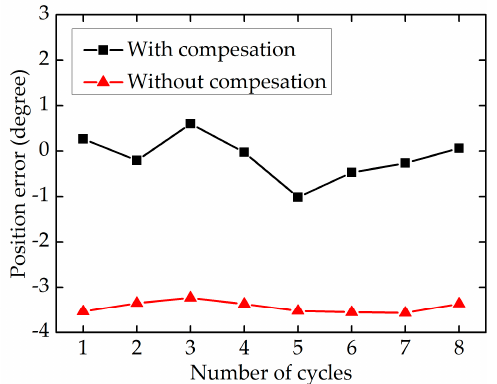
Figure 15. The position error of each cycle.